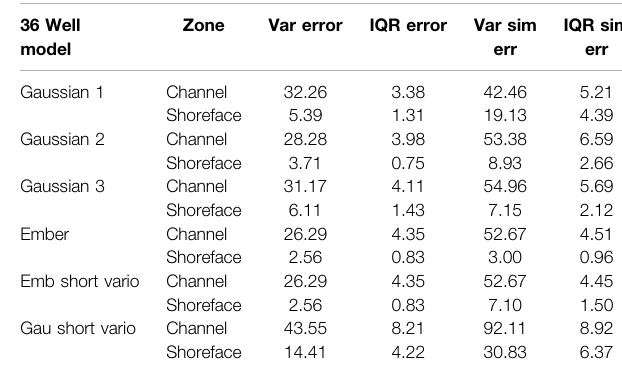
TABLE 2 | Variance of error and IQR for three Gaussian models and the Ember model, as well as for the poor choice of “ short ” variogram for both types, 36- well case.